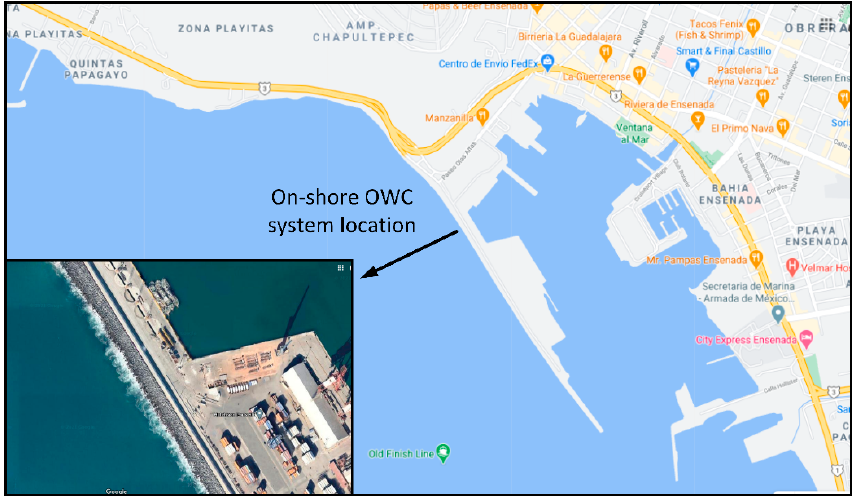
Figure 1. On-shore oscillating water column (OWC) system location proposal in Ensenada City, Baja California. Adapted from Google Maps, 2021.